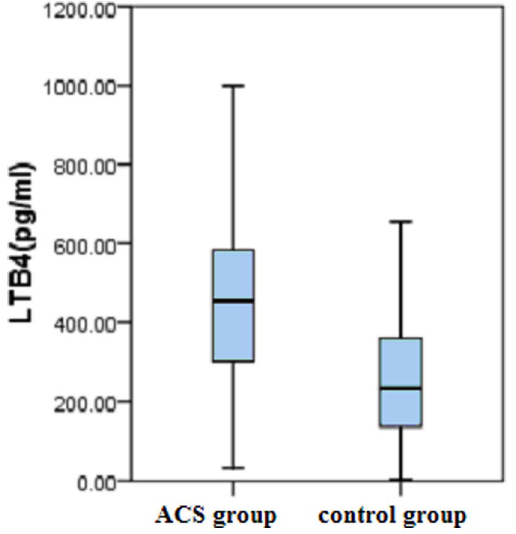
Figure 5. Plot box of serum LTB4 levels (pg/ml) between ACS and control groups. Serum LTB4 level in ACS patients was